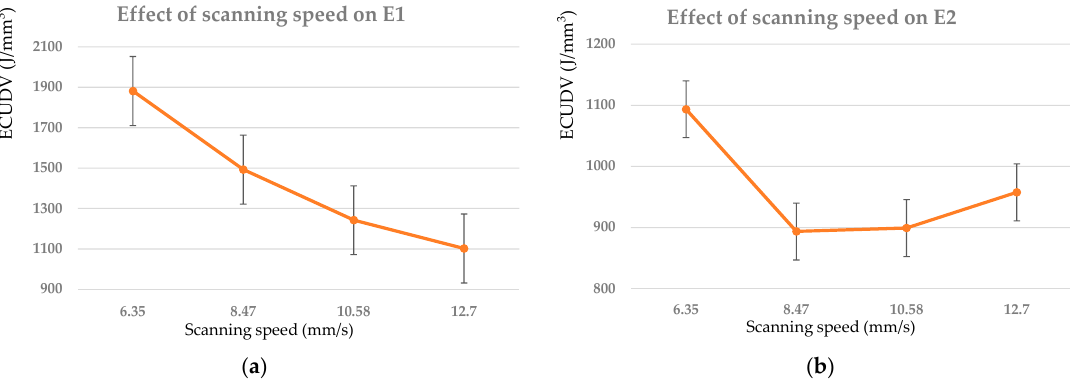
Figure 5. Effect of scanning speed: ( a ) theoretical value and ( b ) actual value. Powder: Inconel 718.